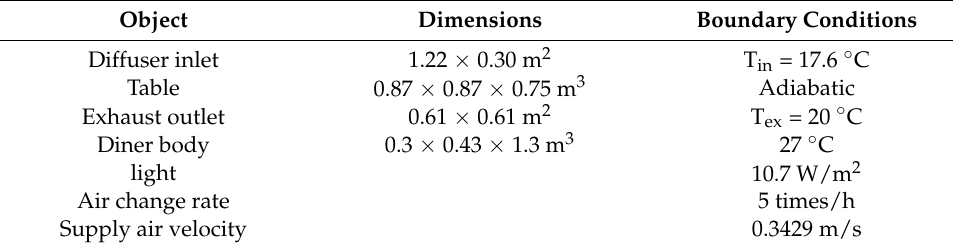
Figure 6. Computer model and components of the restaurant: ( a ) the placement of exhaust outlets and diffuser inlets; ( b ) the locations of all occupants; ( c ) the location of the infected occupant Table 3. Restaurant specifications.